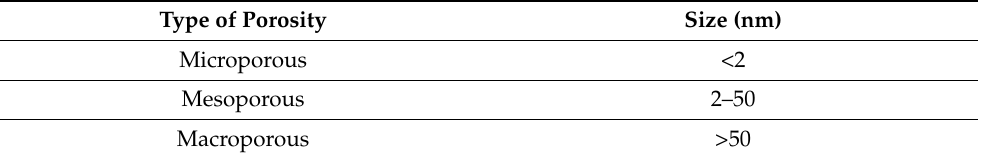
Table 1. Classification of porous materials by pore size.